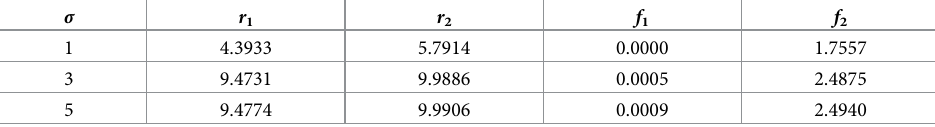
Table 10. One two-step fraction, logistic death.